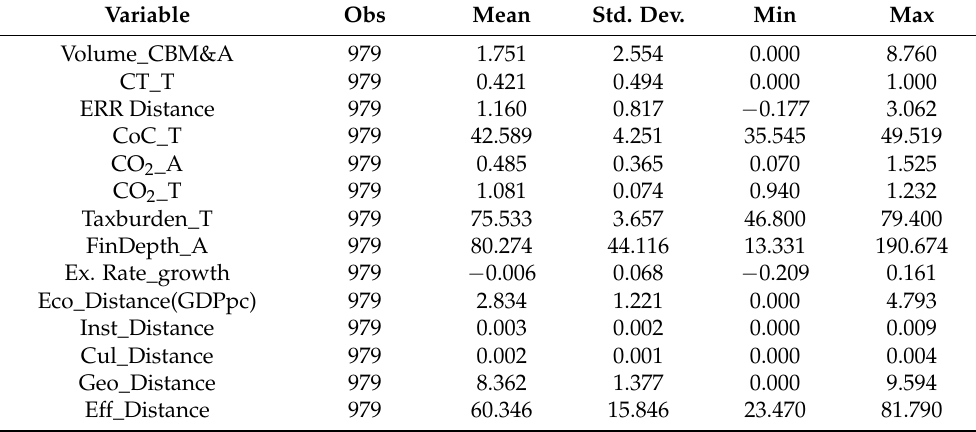
Table 1. Summary statistics of all